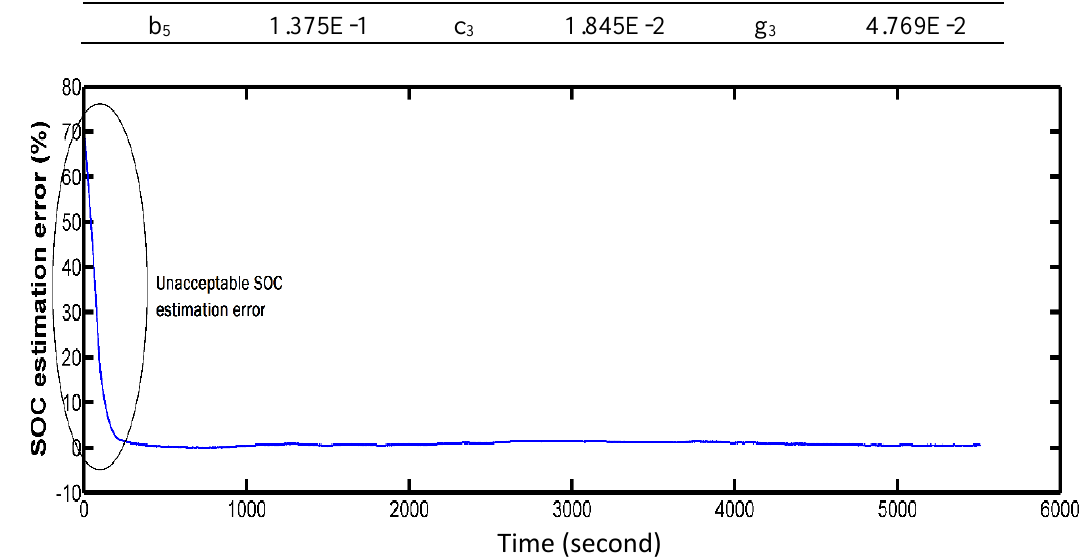
Figure 4. SOC estimation error for a battery pack by improved extended Kalman filter (without using fuzzy estimation for initial